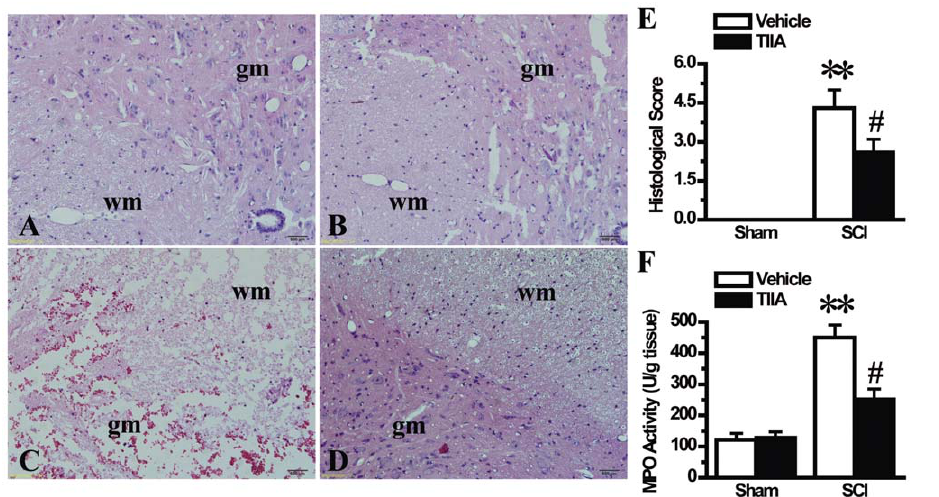
Figure 2. Effects of TIIA on histological changes at 24 h after SCI. Normal structure of spinal cord was observed in the sham (A) and sham/ TIIA (B) groups at 24 h after SCI. A significant damage of spinal cord was shown by the presence of edema, haemorrhage and loose structure tissue at 24 h after SCI (C). A significant protective effect of TIIA (20 mg/kg) was observed in the SCI/TIIA group (D). wm: white matter; gm: gray matter. The histological score was accessed in a blinded manner (E). MPO activity in tissues was significantly increased at 24 h in the SCI group compared with the sham and sham/TIIA groups and was decreased with the treatment of TIIA (F). Bars represent means 6 SEM. ** p , 0.001 vs. sham group, # p , 0.05 vs. SCI group.